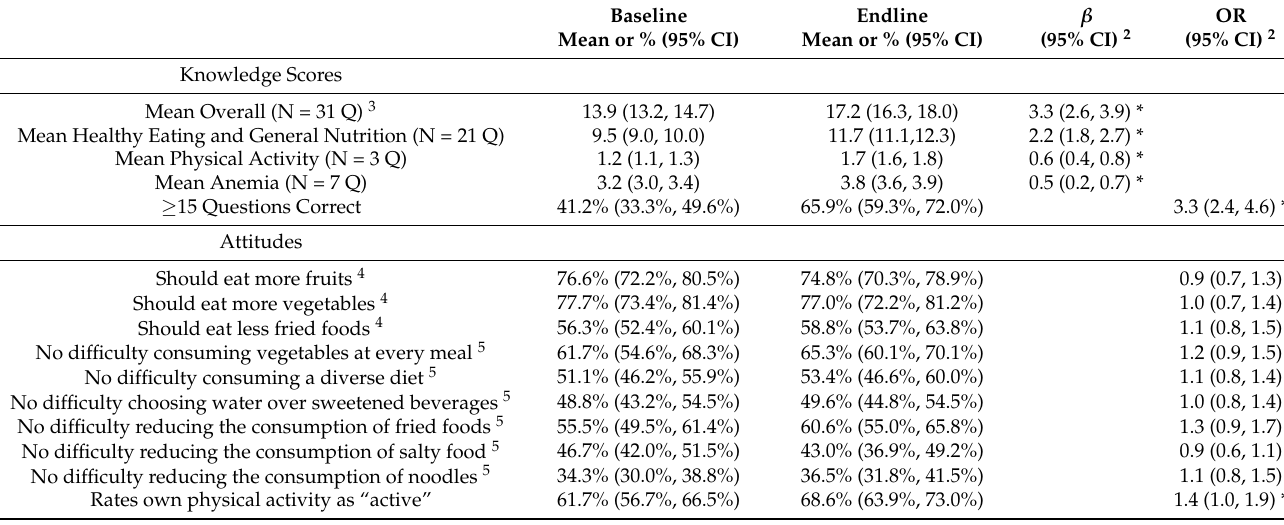
Table 2. Knowledge assessment and healthy eating attitudes among adolescents 1 .